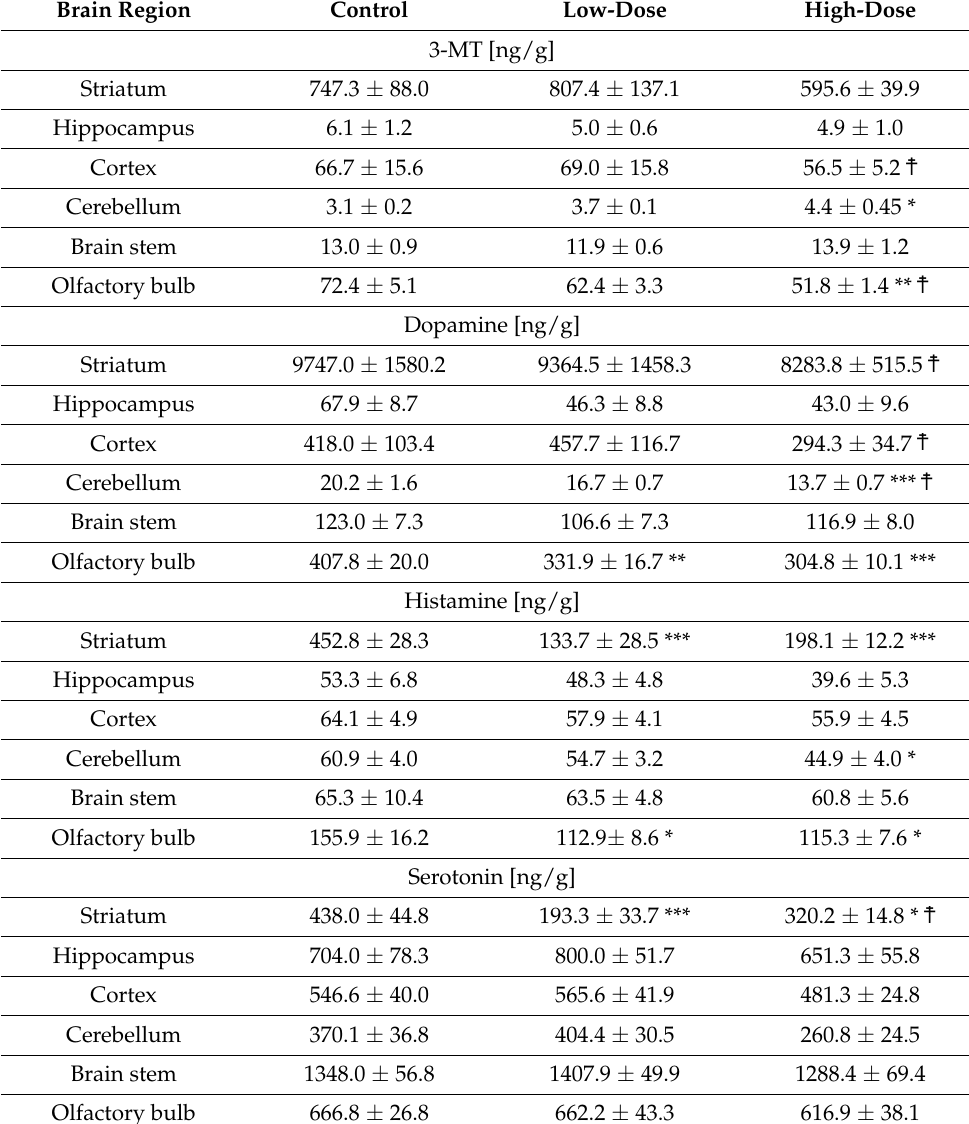
Table 4. The concentration of monoamines in different parts of brain.